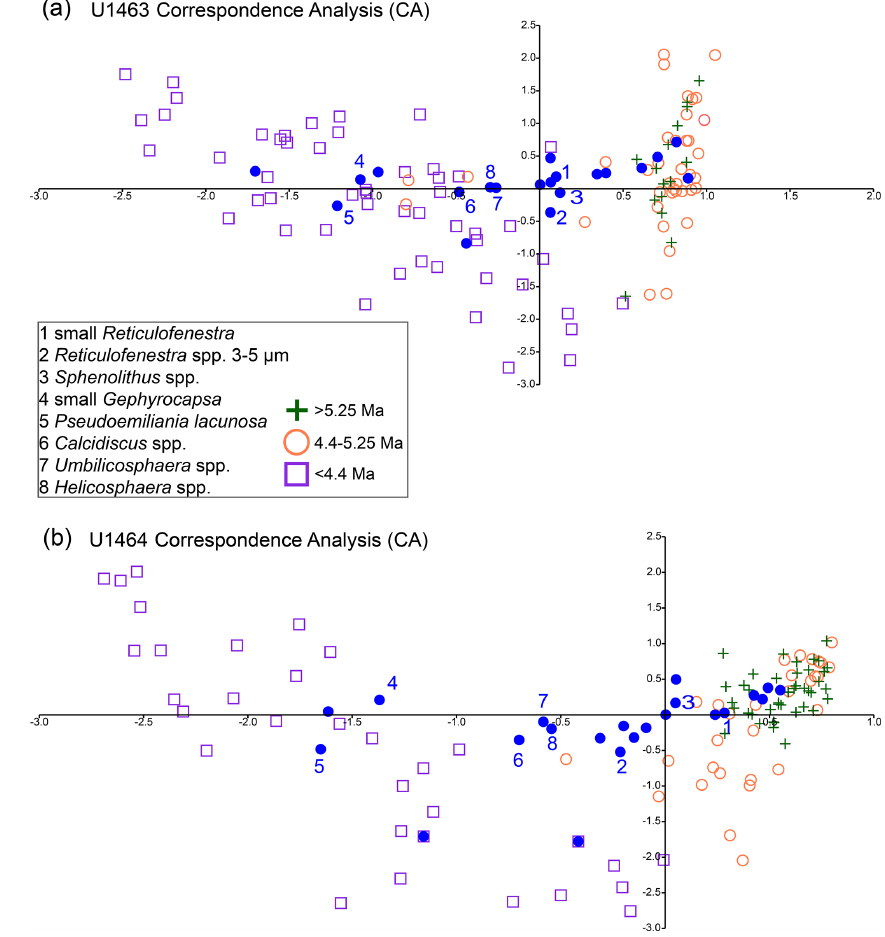
Figure 5. Correspondence analysis for IODP Sites U1463 (a) and U1464 (b) . Orange circles represent samples older than 5.25Ma and, together with the green plus signs (4.4–5.25Ma), constitute the records prior to the significant decrease in NAR that occurred at 4.6–4.4Ma. Purple squares represent sample ages < 4.4Ma. Numbered (1–8) blue dots represent the most common nannofossil species (see